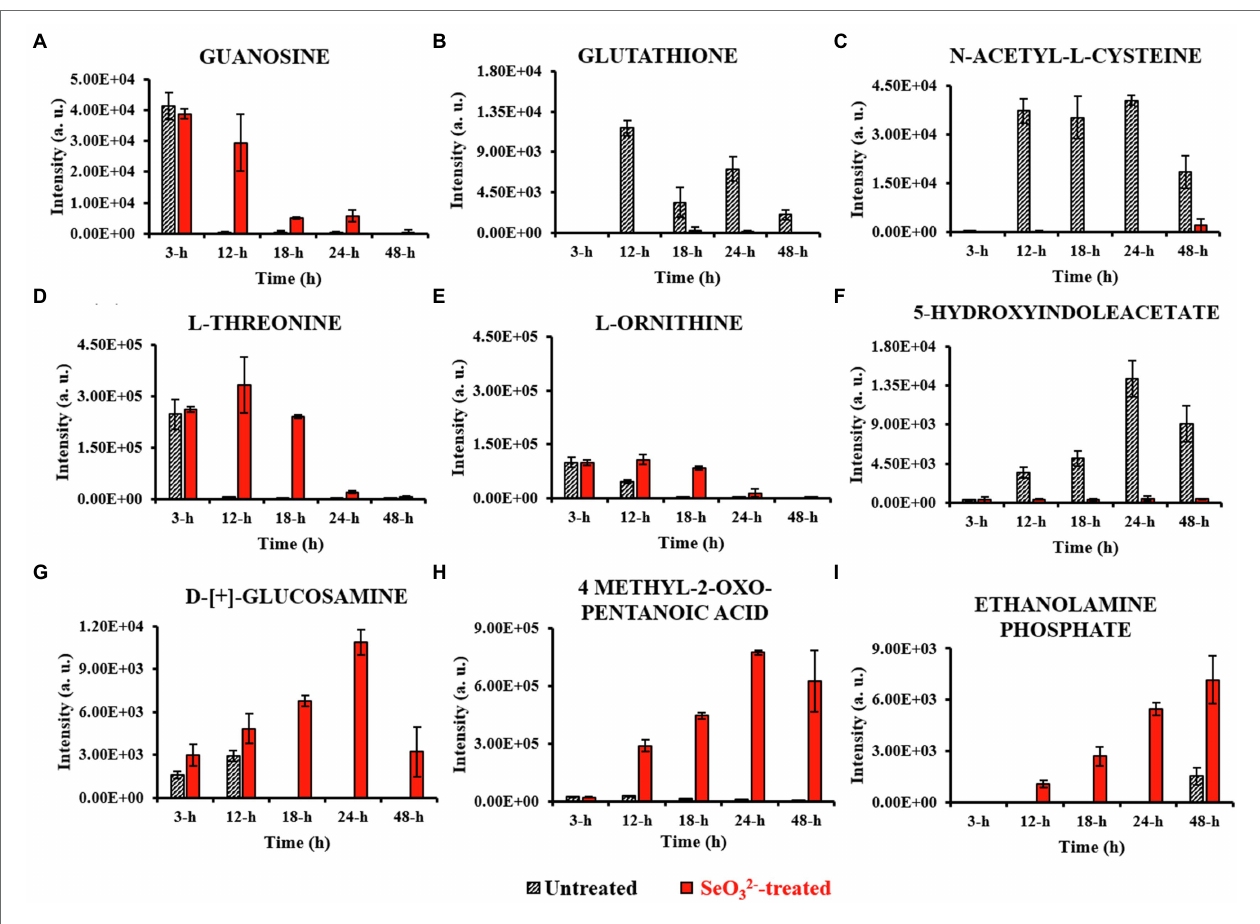
− -treated cells during the 3